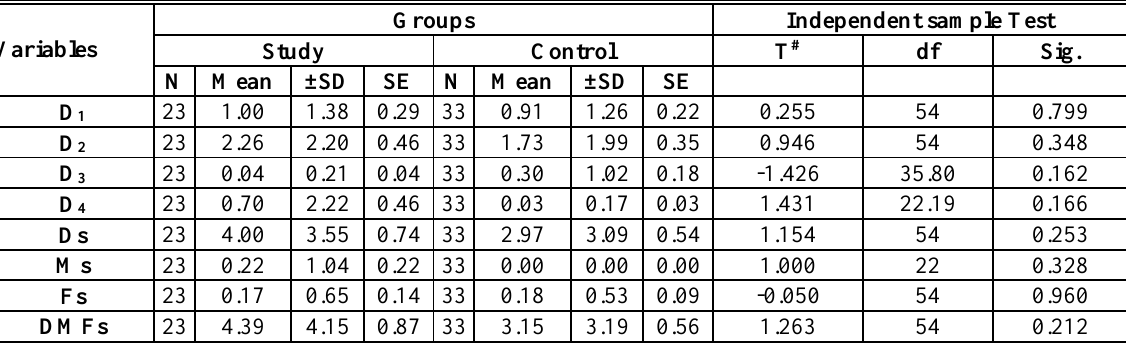
Table 1: Caries experience and caries severity differences between study and control groups for